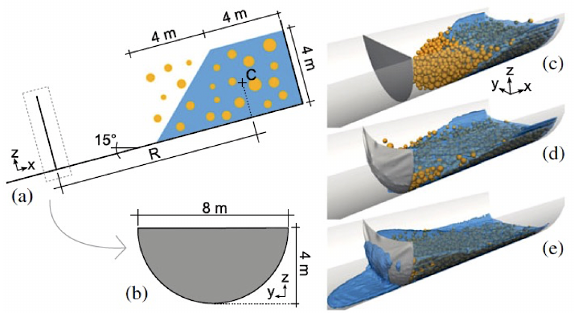
Figure 4. Set-up of numerical simulation (a) Geome- try of the configuration before the simulation starts. (b) Undeformed shape of the barrier. The snapshots on the right show the geometry of the flow before (c), during (d), and after (e) the impact on the barrier